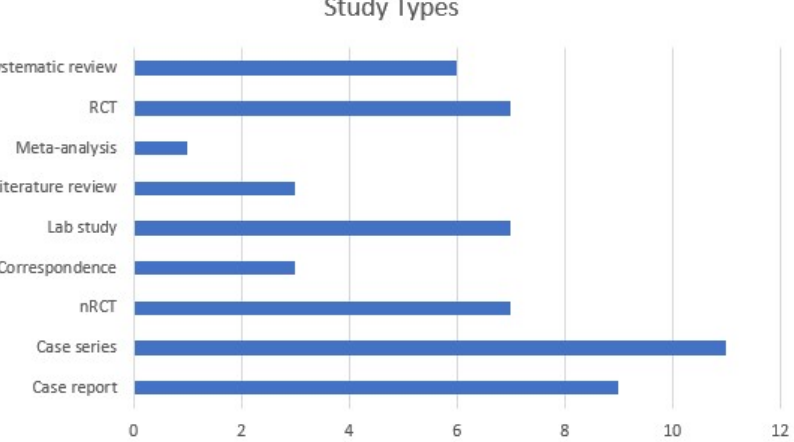
Figure 1. Bar graph showing distribution of study types selected for review. (RCT: randomized controlled trial, nRCT: non-randomized clinical trial).